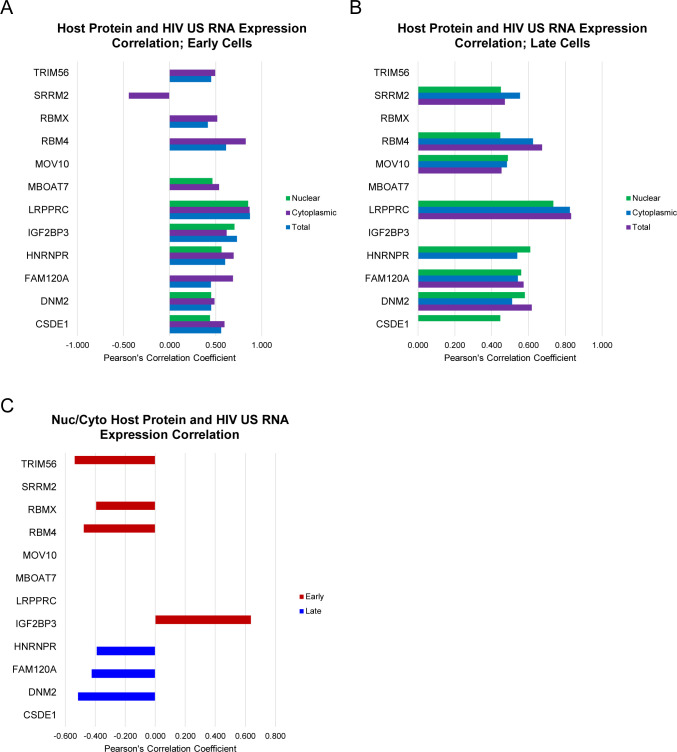
Summary of host protein expression and cellular distribution.(A-B) Pearson’s correlation coefficient for host protein expression and unspliced (US) HIV RNA expression in early cells (A) and late cells (B). (C) Pearson’s correlation coefficients for the ratio of nuclear/cytoplasmic host protein intensity and US HIV RNA expression in early and late cells. For A, B, and C, only proteins with R>0.35 and R2>0.15 are displayed. Related to Figure 5 and Figure 5—source data 1.